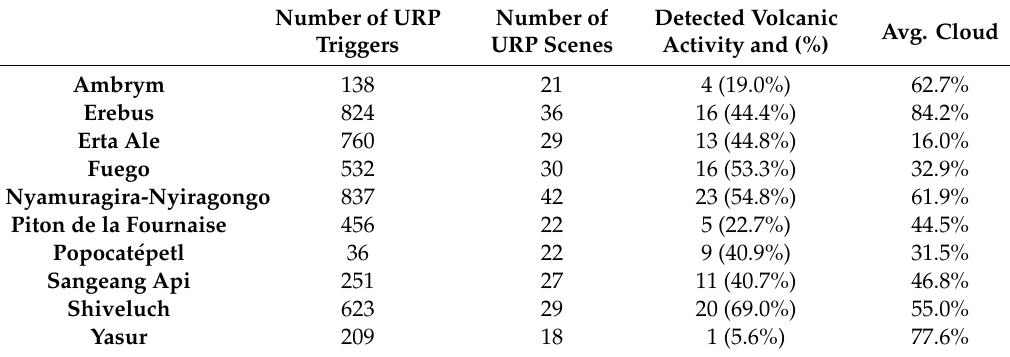
Table 2. Statistical analysis of ten URP-monitored volcanoes active during one year (1 June 2018 to 31 May 2019). Each ASTER scene was inspected for confirmed / detected volcanic activity (e.g., thermally elevated pixels, presence of a plume) and average cloud cover. The percentage of those URP scenes with confirmed activity is also given and generally correlates to the average cloud percentage. Number of URP Number of Detected Triggers URP Scenes